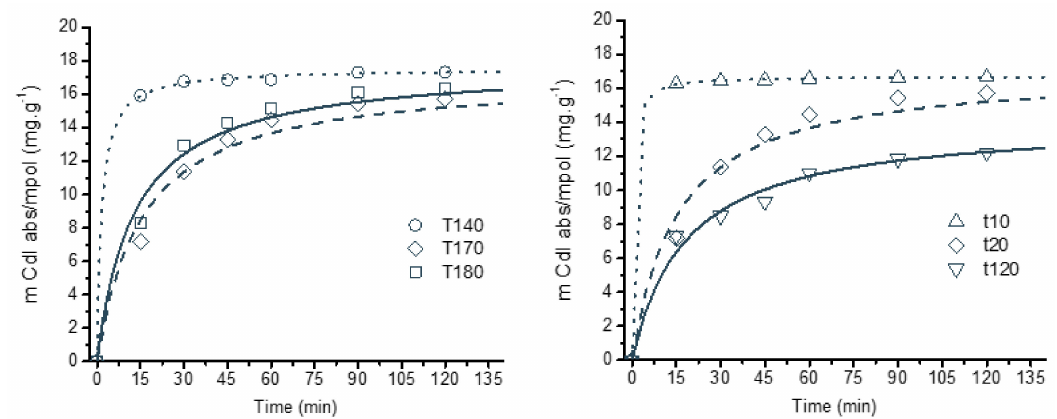
Figure 5. Sorption kinetics of indigo carmine (measured in mg absorbed per gram of resin) for the chitosan matrices prepared at three di ff erent temperatures ( left ) and at the same temperature (170 ◦ C) for di ff erent times ( right ). (Lines represent curve fittings using a pseudo second order model, Table